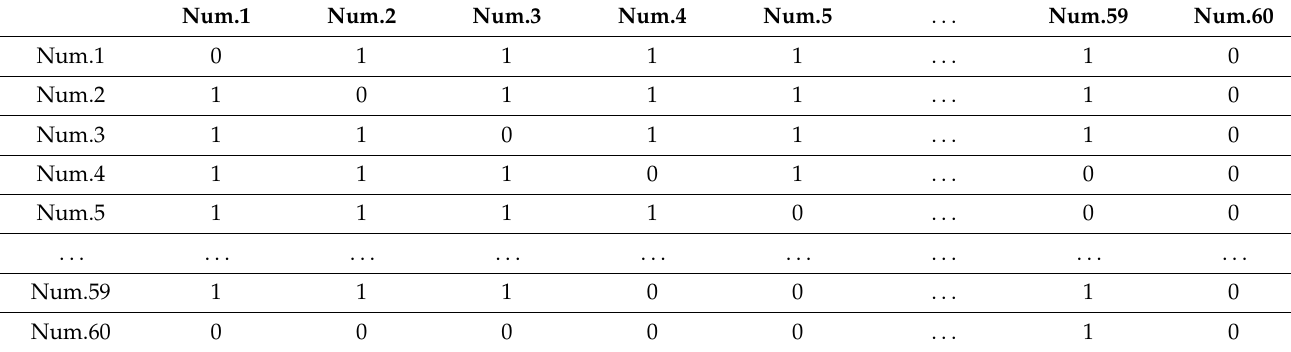
Table 2. 60 × 60 guanxi matrix in Case